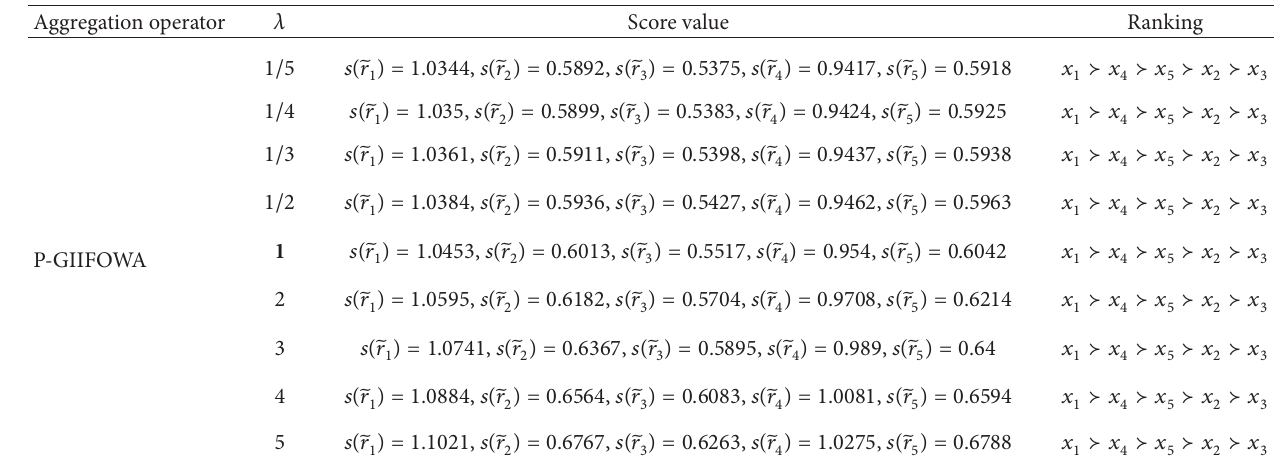
Gaussian-GIIFOWG